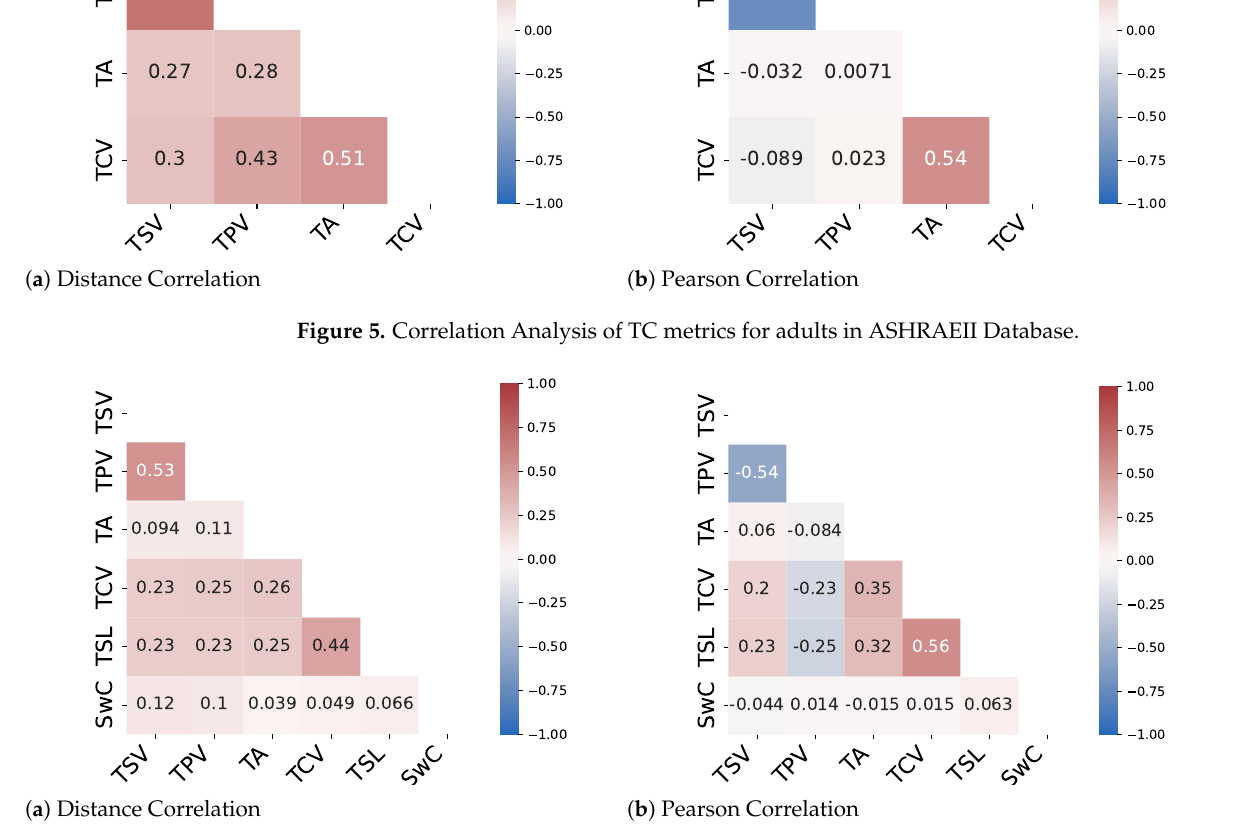
Figure 6. Correlation Analysis of TC metrics in primary student data. Table 1. Principal Component Analysis of Primary Student